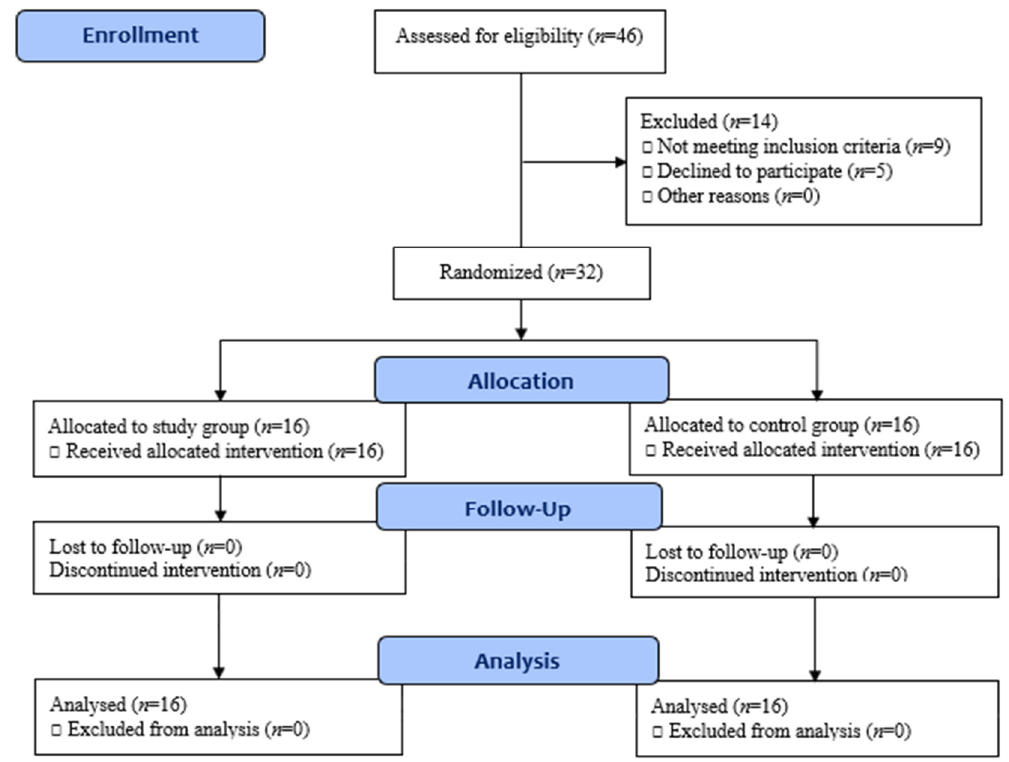
Figure 1. The CONSORT flow diagram of the study.